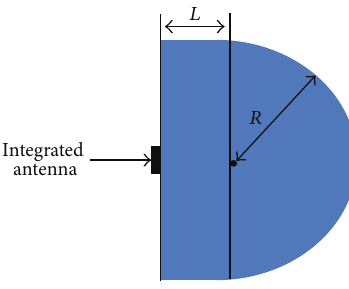
Figure 10: Schematic diagram of hyperhemispherical lens.